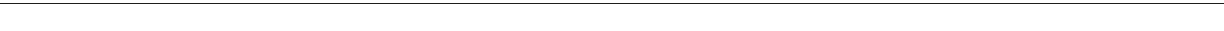
Fig. 1 Characterisation of pulmonary pericytes during alveologenesis. a , b Three-dimensional reconstruction ( a ) and high magni fi cation thin optical section ( b ) of confocal images with Airyscan detection showing AQP5-stained type 1 alveolar epithelial cells (green), PDGFR β -stained pulmonary pericytes (PCs) (red) and PECAM1-stained endothelial cells (ECs) (blue) in lung at 4 weeks. Panels on the right show higher magni fi cation of corresponding insets ( a ) or single channels ( b ). Scale bar, 30 µ m ( a , left), 15 µ m ( a , right), 10 µ m ( b , left) and 5 µ m ( b , right panels). c , d Three-dimensional reconstruction ( c ) and thin optical section ( d ) of confocal images showing SFTPC-stained, cuboidal AT2 cells (green), PDGFR β -stained PCs (red) and RAGE-stained AT1 cells (blue) in lung at 4 weeks. Panels on the right show higher magni fi cation of corresponding insets. Scale bar, 20 µ m (left), 10 µ m (right). e Quantitation of EC to PC ratio as measured in peripheral lung sections at different developmental stages. Data represents mean ± s.e.m. ( n = 5 for P7, n = 6 for P21 and Adult mice). f Scheme showing the time points of tamoxifen administration (P1 – 3) and analysis for the Pdgfrb(BAC)-CreERT2 R26-mT/mG mice. g – k High magni fi cation images of Pdgfrb(BAC)-CreERT2 R26-mT/mG lung sections at indicated stages showing pulmonary GFP + PCs (green), PECAM1 + ECs, PDGFR β + PCs, PDGFR α + fi broblasts or α SMA + bronchial smooth muscle cells/myo fi broblasts (red, as indicated). Arrows in g indicate PC cell bodies, in g – k GFP-positive PDGFR β + cells ( g , h ), GFP-negative PDGFR α + cells ( i ) or α SMA + cells ( j , k ) are marked. Scale bar, 20 µ m ( g , h ), 15 µ m ( i , k ) and 30 µ m ( j ). l RT-qPCR analysis of Pdgfrb (pericytes), Pecam1 (endothelium), and Sftpc (epithelium) expression in freshly sorted GFP + , CD31 + or EpCAM + cells from P7 Pdgfrb (BAC)-CreERT2 R26-mT/mG lung. Data represents mean ± s.e.m. ( n = 4